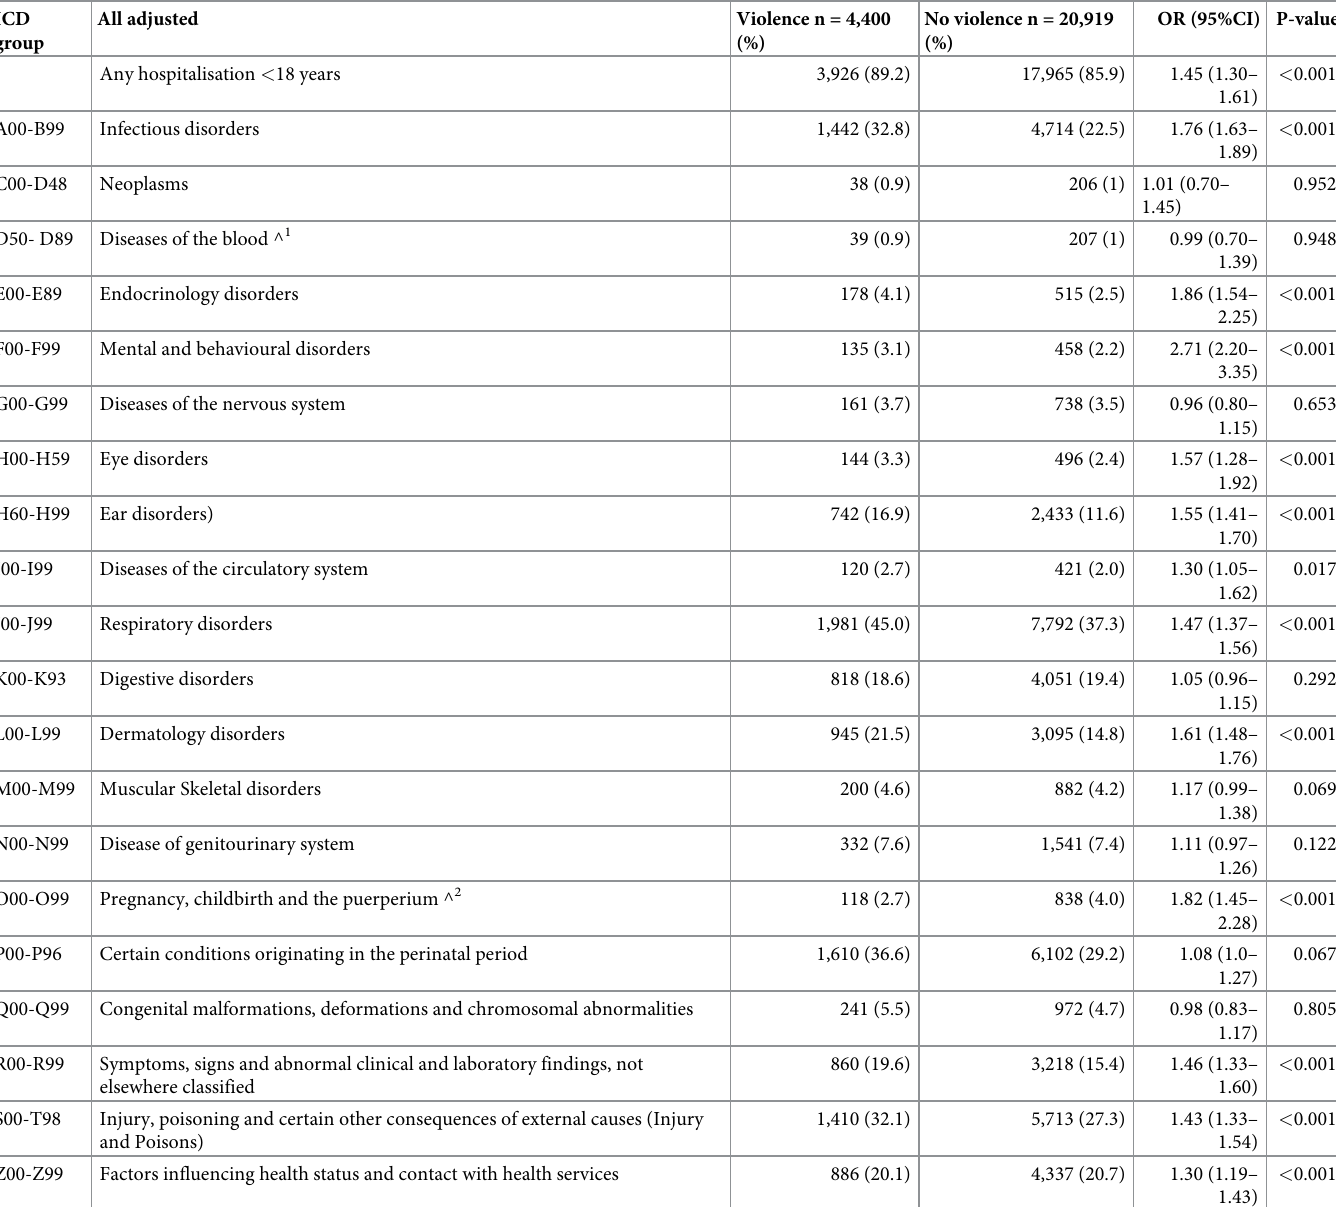
Table 5. Adjusted � principal hospitalisations for Aboriginal children exposed and non-exposed to FDV in early childhood period. ICD